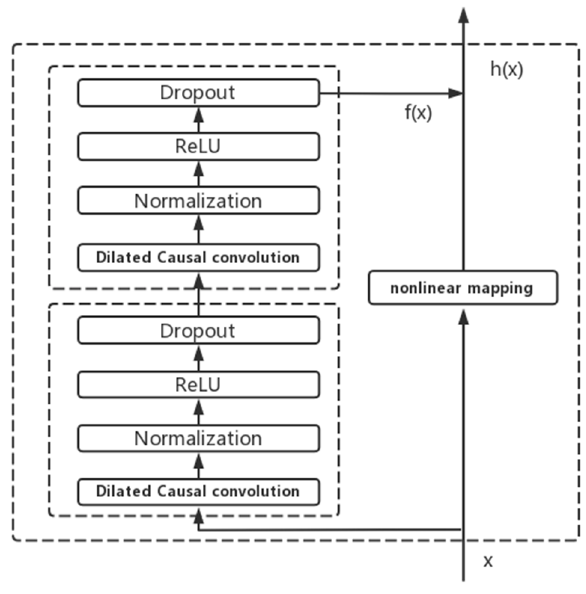
Figure 3. Residual block.